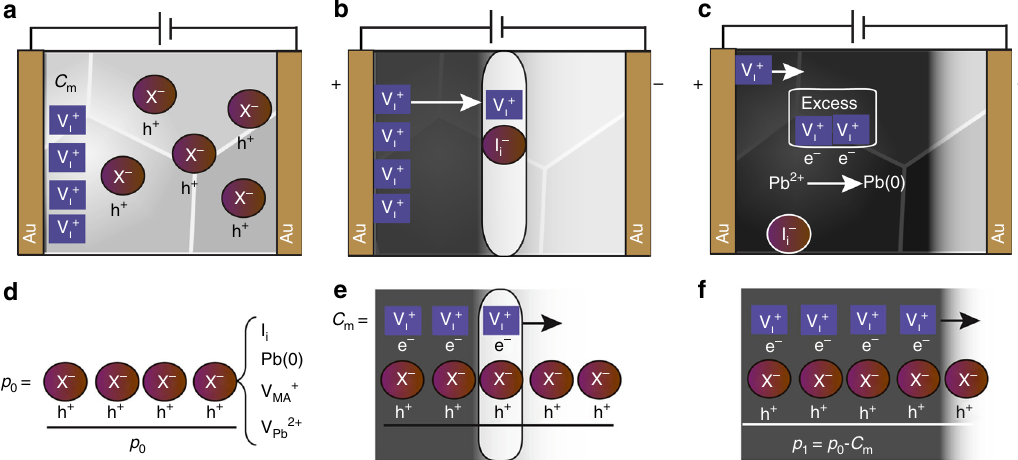
Fig. 4 Interpretation of the dominant ionic effects. Diagrams with a proposal of the processes taking place during the application of an electrical fi eld in the lateral electrode con fi guration. a and d represent the initial state with a background of p -dopants ( p 0 ) and iodine vacancies present at the interface with the electrode. b , e When the electrical fi eld is applied, vacancies migrate toward the negative electrode, in this transit, they partially compensate the charge of the background doping, including some non-radiative recombination defects (I i ). c , f Excess vacancies carry excess of electrons that can lead to generation of other PL quenching defects such as